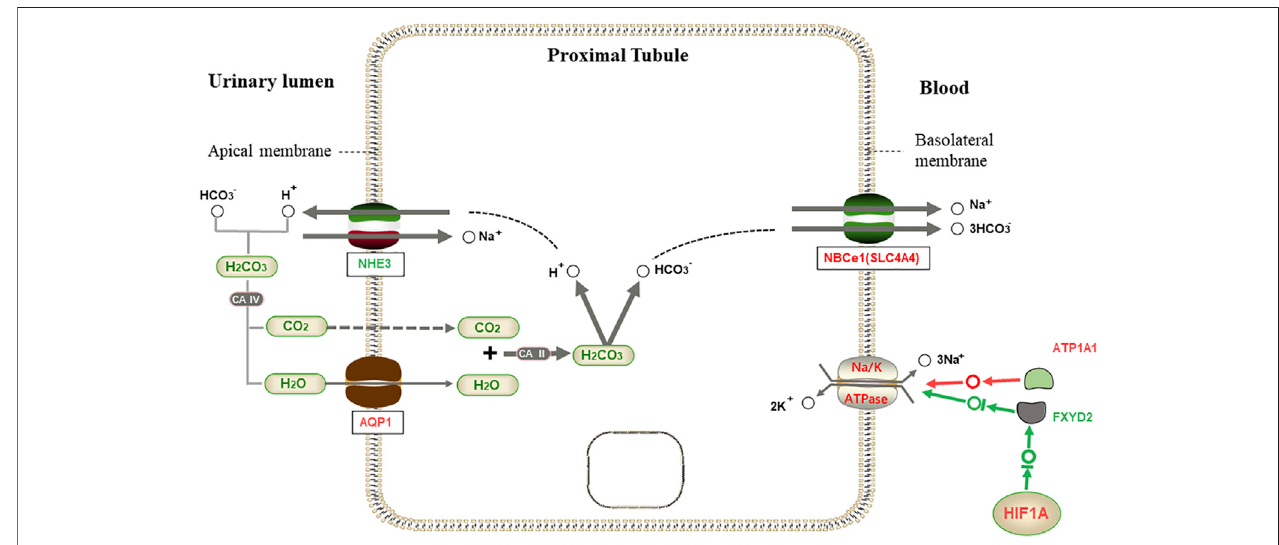
FIGURE9| Proximaltubulebicarbonatereclamation.WhenHCO 3 − isneededbythebody,HCO 3 − intheallantoiccavitysynthesesH 2 CO 3 withH + releasedbyNa + / H + exchanger ( NHE3 ), which is decomposed into CO 2 and H 2 O under the action of CA Ⅳ . H 2 O enters proximal tubule cells through aquaporin 1 ( AQP1 ), and is synthesized with CO 2 to produce H 2 CO 3 under the action of CA Ⅱ , then decomposed into H + and HCO 3 − . Then, Na + /3HCO 3 − cotransport is mediated by Na + /3HCO 3 − Cotransporter NBCe1 ( SLC4A4 ).However,NA-K-ATPaseistransportedoutofthecellwiththreeNa + onthebasolateralmembrane,andtwoK + areexchangedinto the cell to maintain the osmotic gradient. Among genes and proteins, red represents up-regulated expression in L. yarkandensis , and the green represents down- regulatedexpressionin L.yarkandensis .Theredarrowrepresentspromotingexpressionregulation,andthegreenarrowrepresentsinhibitingexpressionregulation.Na- K-ATPase α 1 subunit ( ATP1A1 ) and regulatory FXYD subunit ( FXYD2 ) are component subunits of NA-K-ATPase, and HIF1A is a transcription factor protein.